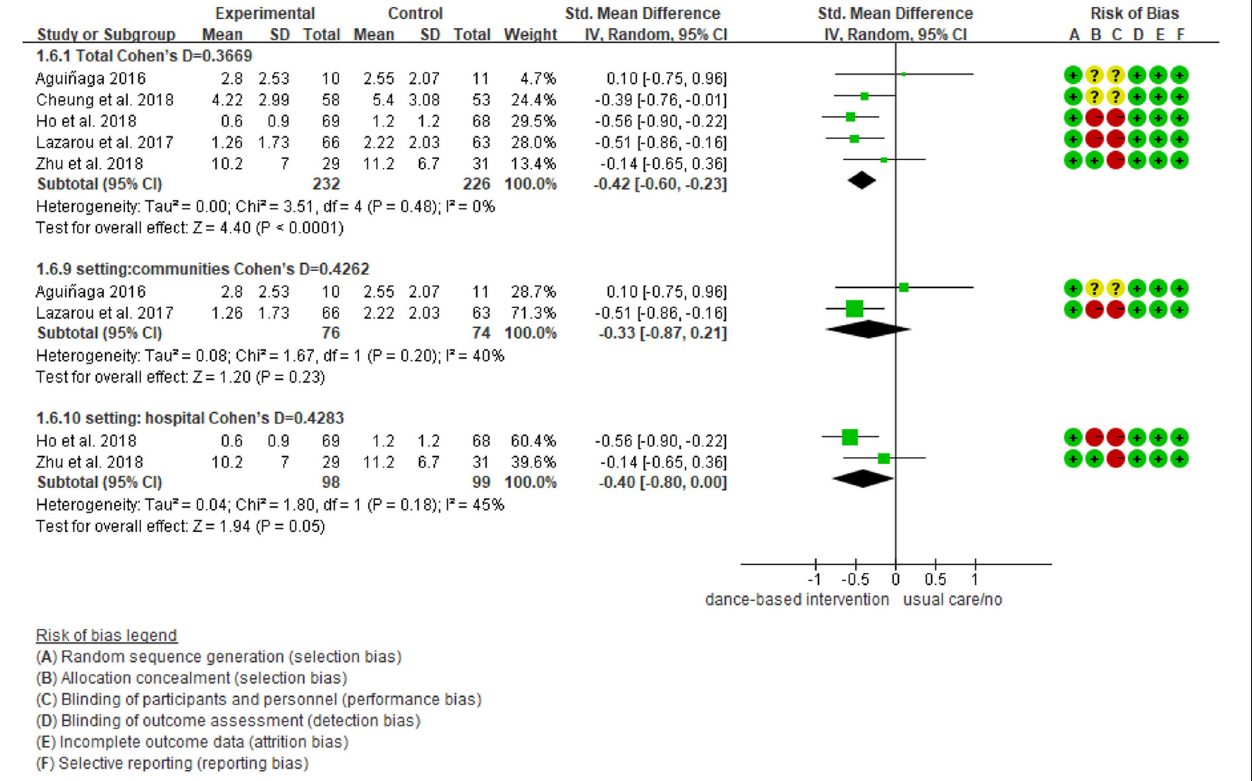
FIGURE 8 | Subgroup analyses of the intervention group vs. the control group on depression rating scores: Intervention